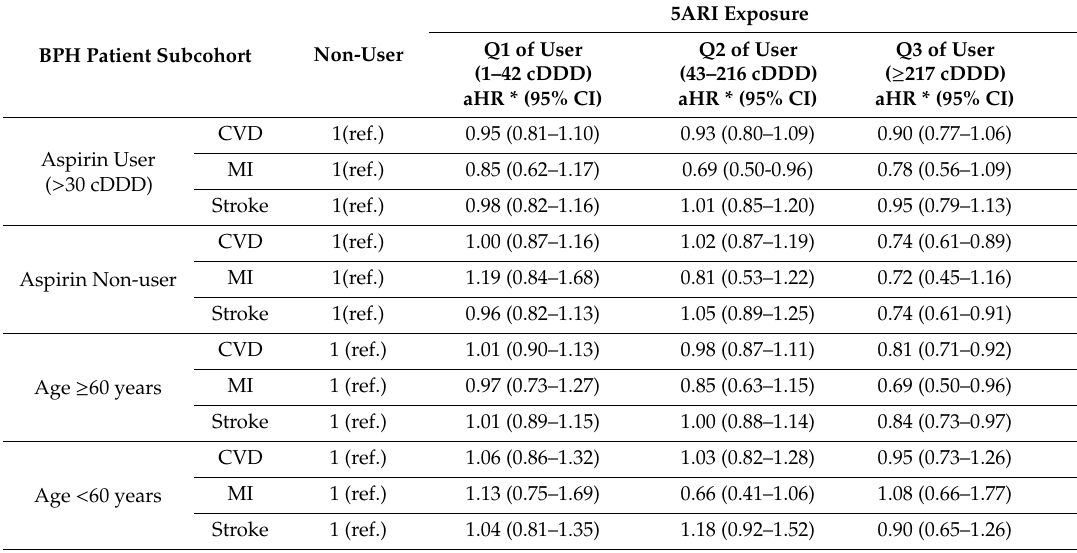
Table 3. Hazard Ratios of 5ARI users (tertiles) vs. non-users of BPH patient subcohort, stratified by aspirin use and